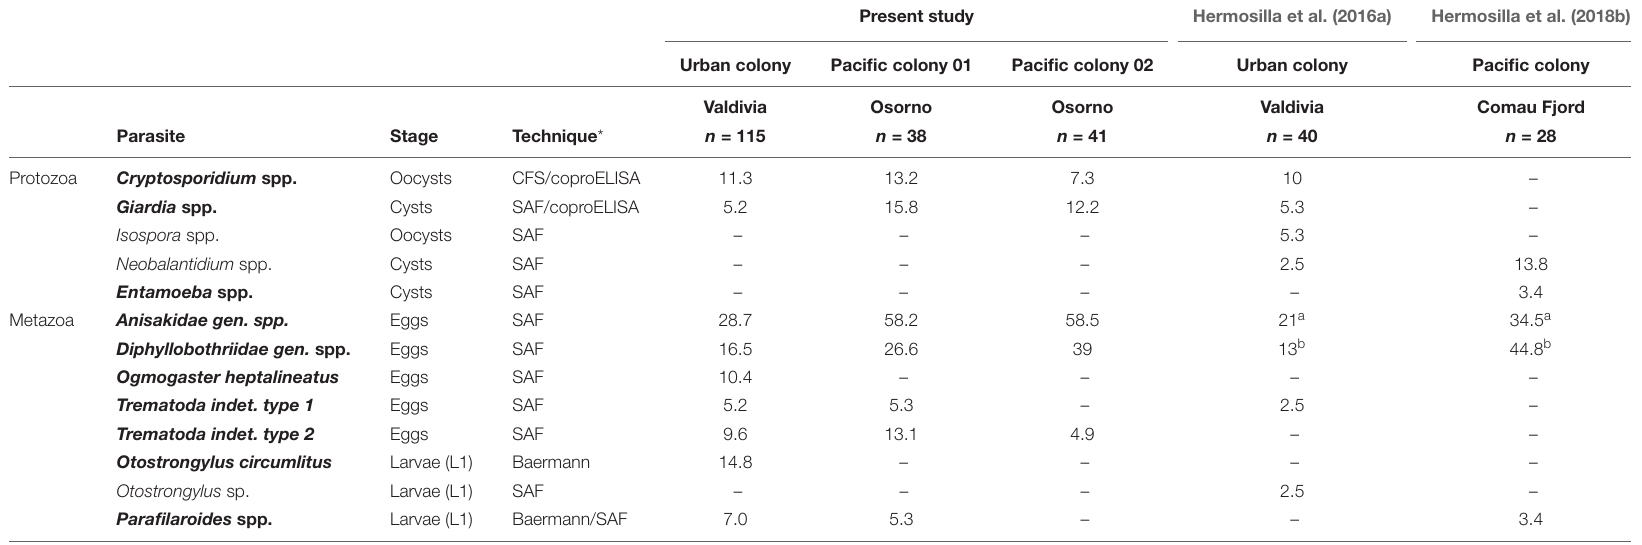
TABLE 2 | Prevalences (%) of protozoan and metazoan endoparasites detected in Otaria flavescens scat samples within this study, including comparison with previous non-invasive fecal sample monitoring studies from Chile.